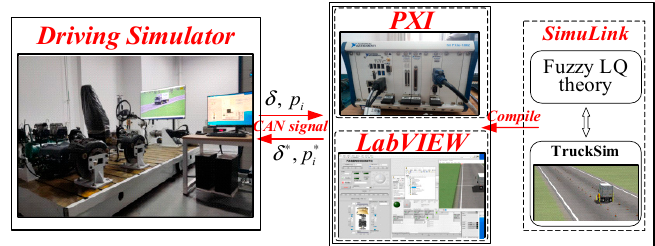
Figure 6. Commercial vehicle hardware-in-loop experiment bench. The system control flow of the hardware-in-loop experiment is shown in Figure 7. The road information used in the experiment is shown in Figure 8. The single-line-change path is the test condition for Scenario 1, and the double-line change path is the test condition for Scenario 2.